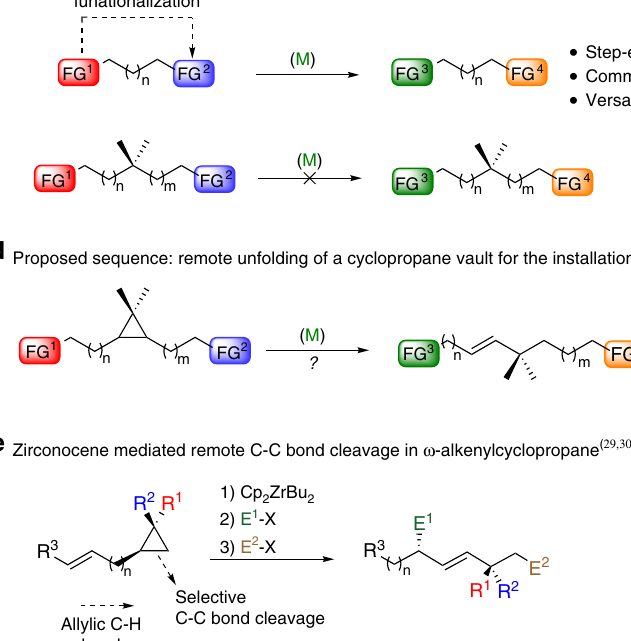
base (2.5 equiv), tert-butylammonium chloride (2 equiv) and molecular sieves 4 Å (150 mg mmol (cid:2) 1 substrate), 1a and PhI (1.2 equiv) in tetrahydrofuran (THF) at 95 (cid:2) C for 24 h afforded a